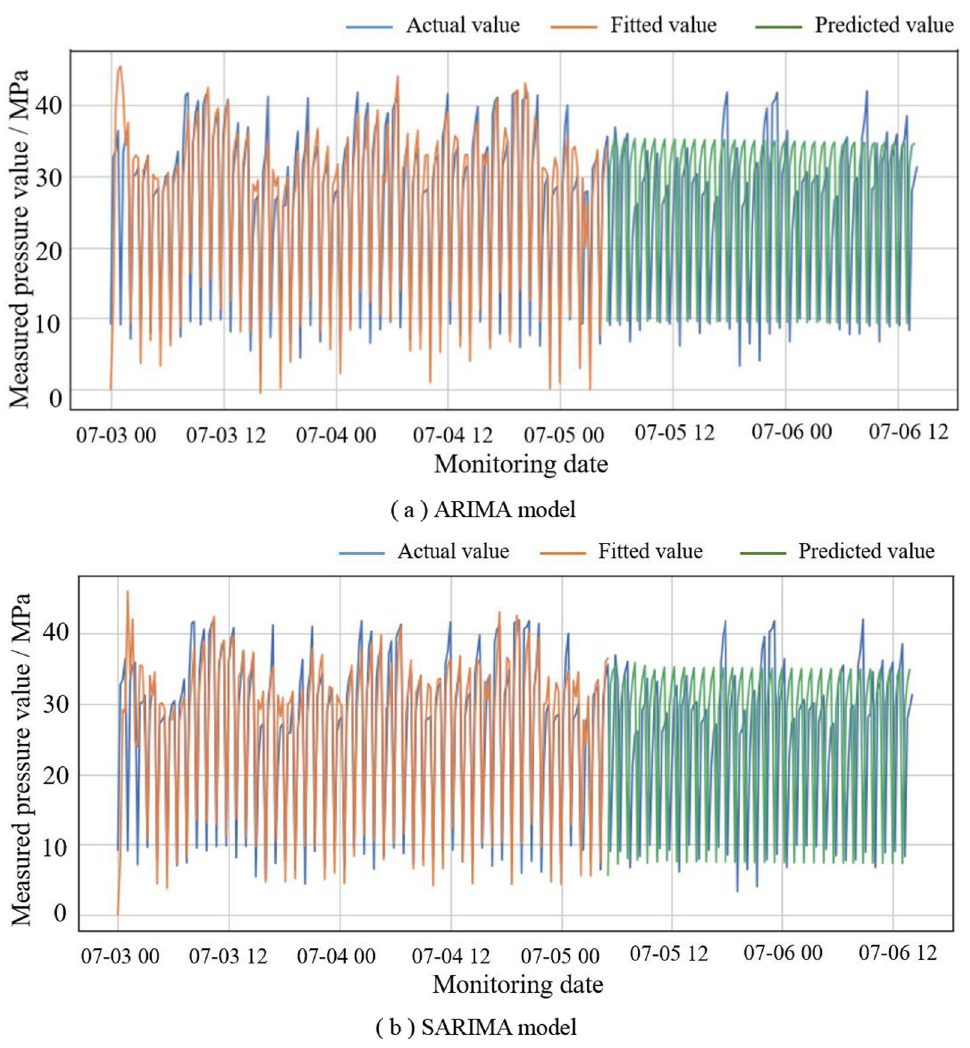
Fig. 13 Different models to predict the support load over multiple cycles Table 3 Prediction effect of the different algorithms One support